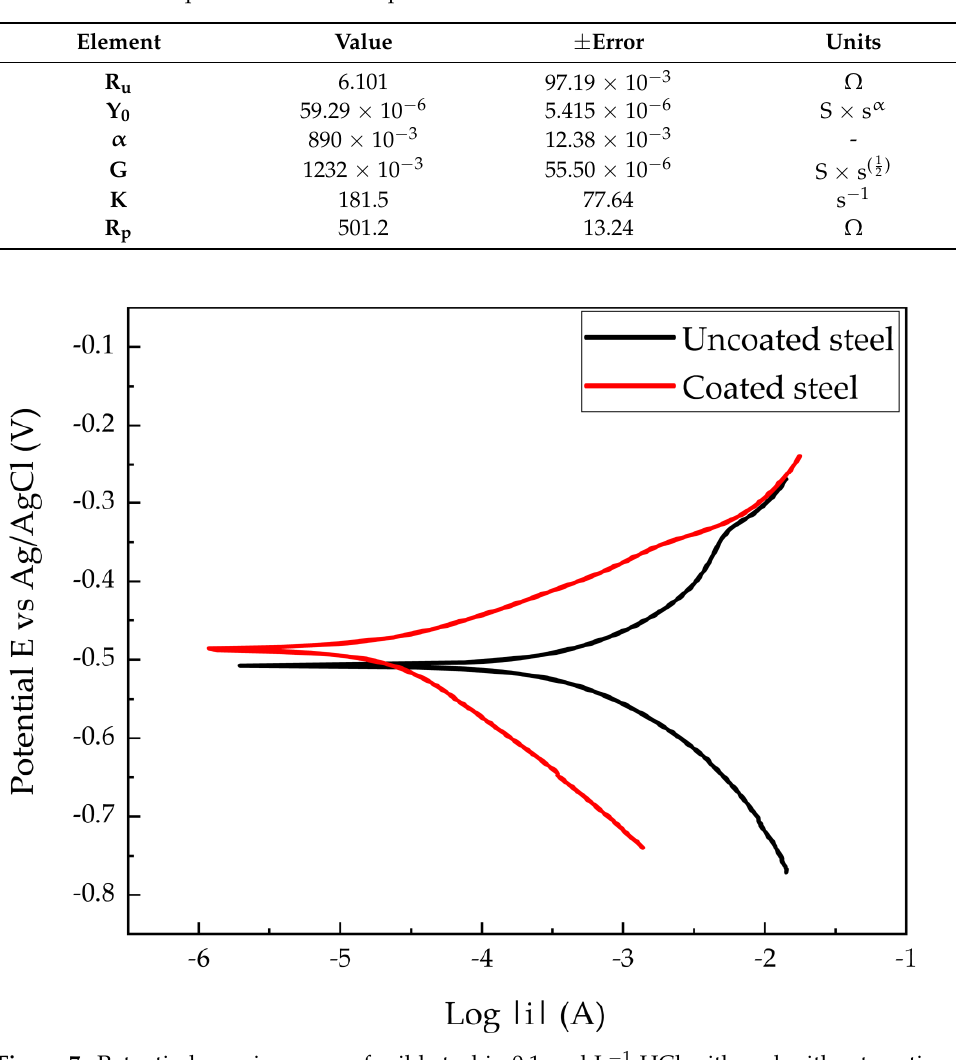
Table 4. Value of equivalent circuit components for coated steel.